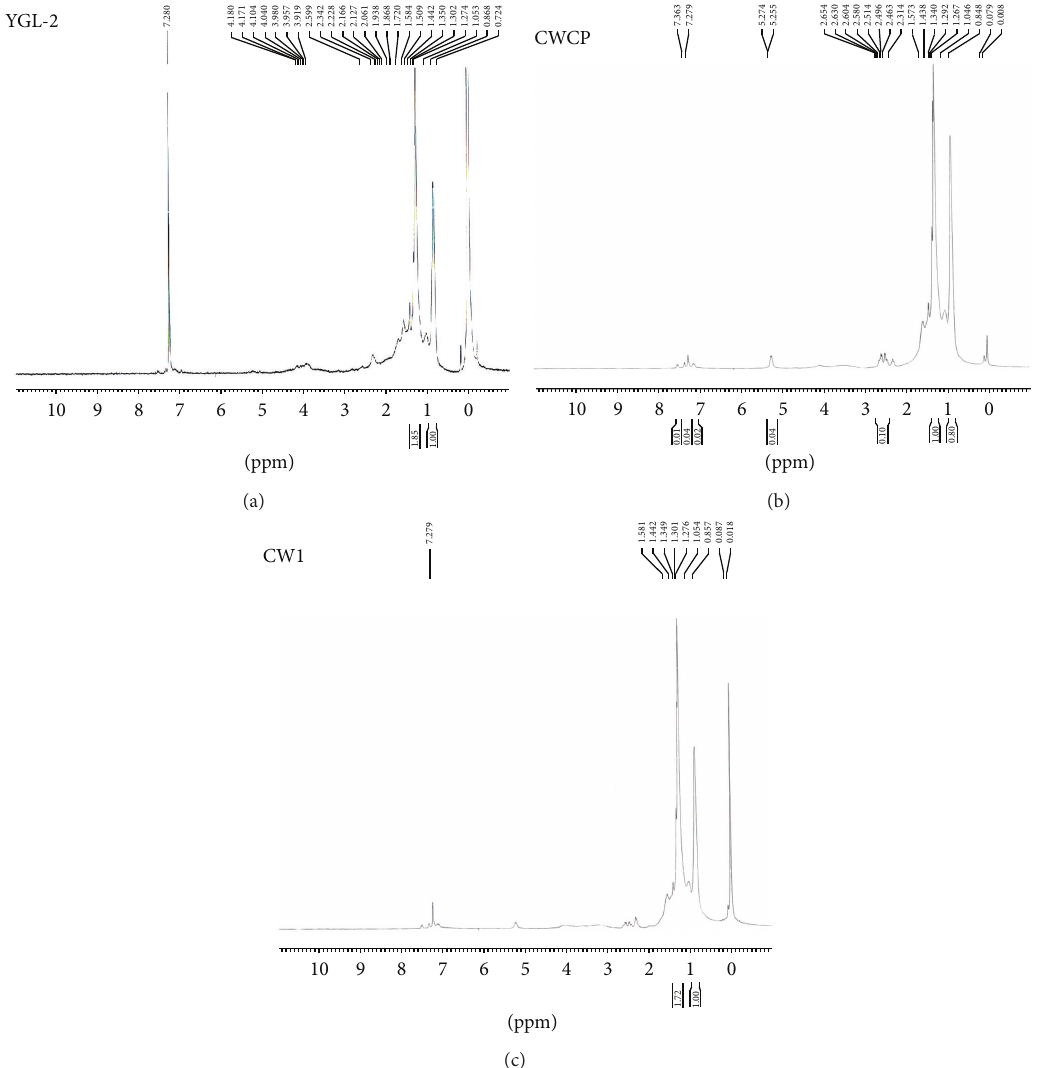
Figure 3: 1 H NMR spectra of extracted PHB from isolates: (a) PHB standard (PHB Sigma Aldrich), (b) NAP11, and (c)